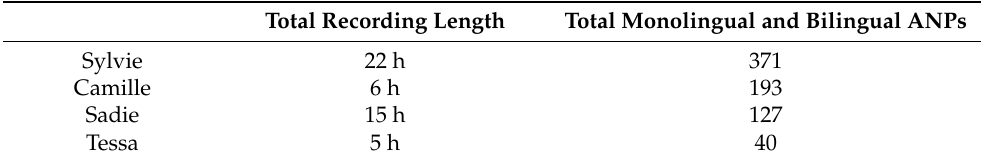
Table 2. The summary of differences between the datasets. Total Recording Length Total Monolingual and Bilingual ANPs Sylvie 22 h 371 Camille 6 h 193 Sadie 15 h 127 Tessa 5 h